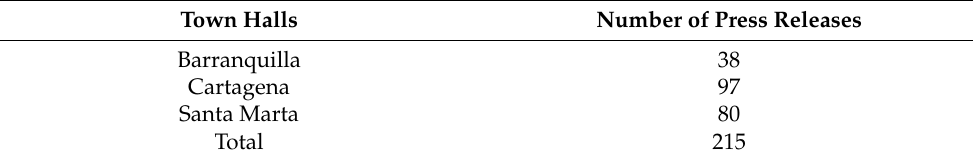
Table 1. Number of press releases per town hall (Source: Authors).